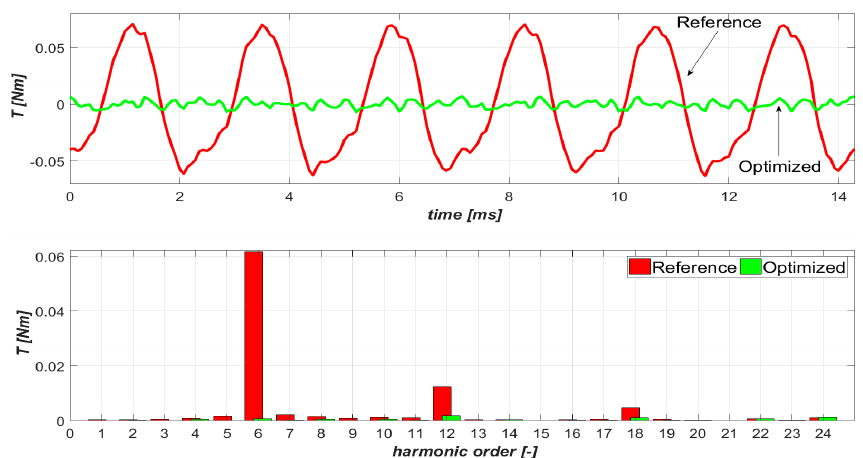
Figure 7. Torque ripple waveforms and their harmonic content (second structure of n s / n p equal to 9/8).